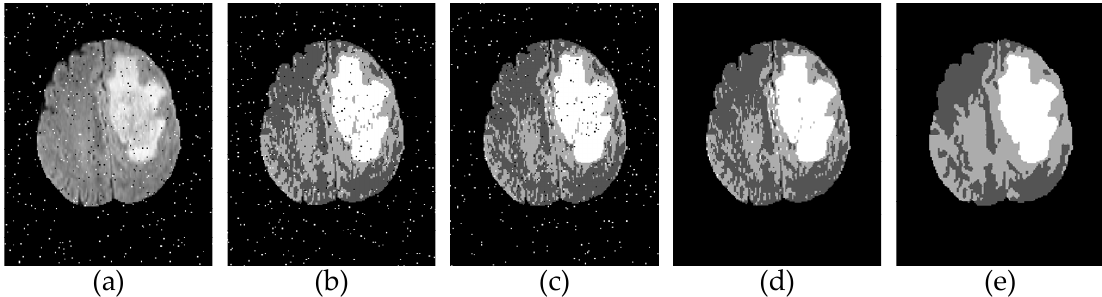
Figure 2. Step-by-step results of the intuitionistic fuzzy C-means algorithm based on membership filtering and similarity measurements (IFCM-MS). ( a ) Original image. ( b ) Fuzzy C-means algorithm (FCM). ( c ) FCM + intuitionistic fuzzy set (IFS). ( d ) FCM + IFS + membership information transfer model. ( e ) FCM + IFS + membership information transfer model + similarity measurements.